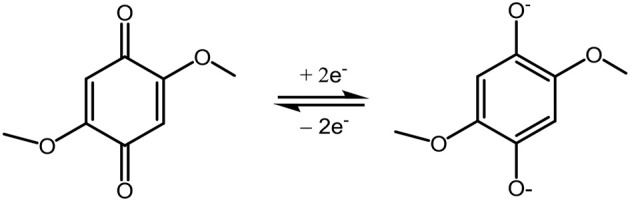
Electron redox mechanism of DMBQ.